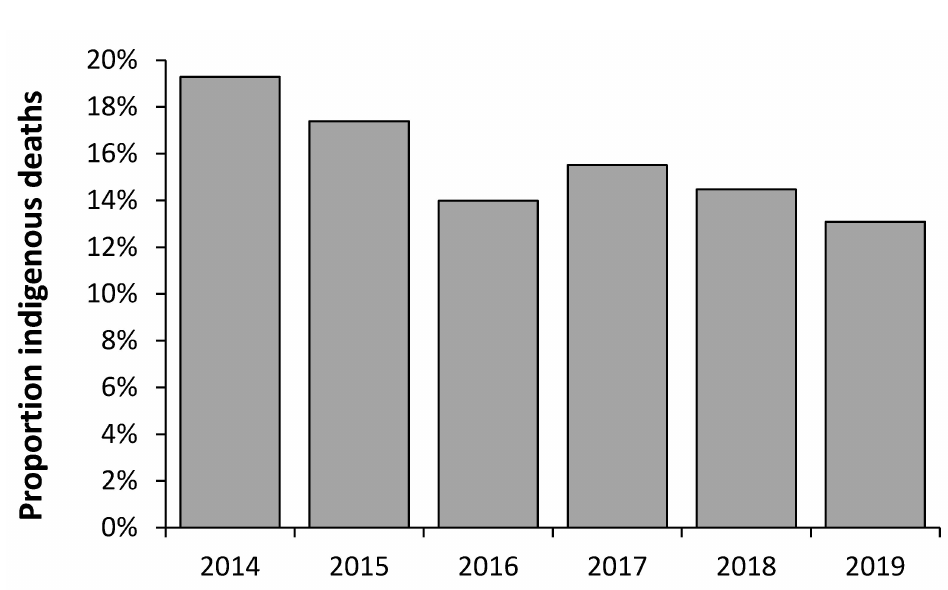
Figure A1. Proportion of total Australian Indigenous deaths occurring in the Northern Territory